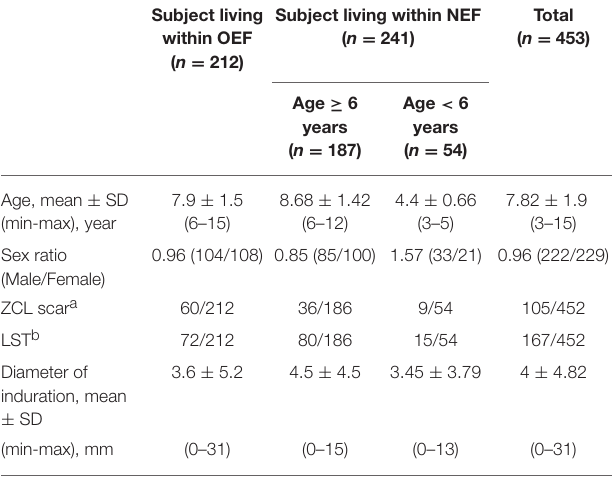
TABLE 2 | Clinical and immunological data of subject included on the prospective